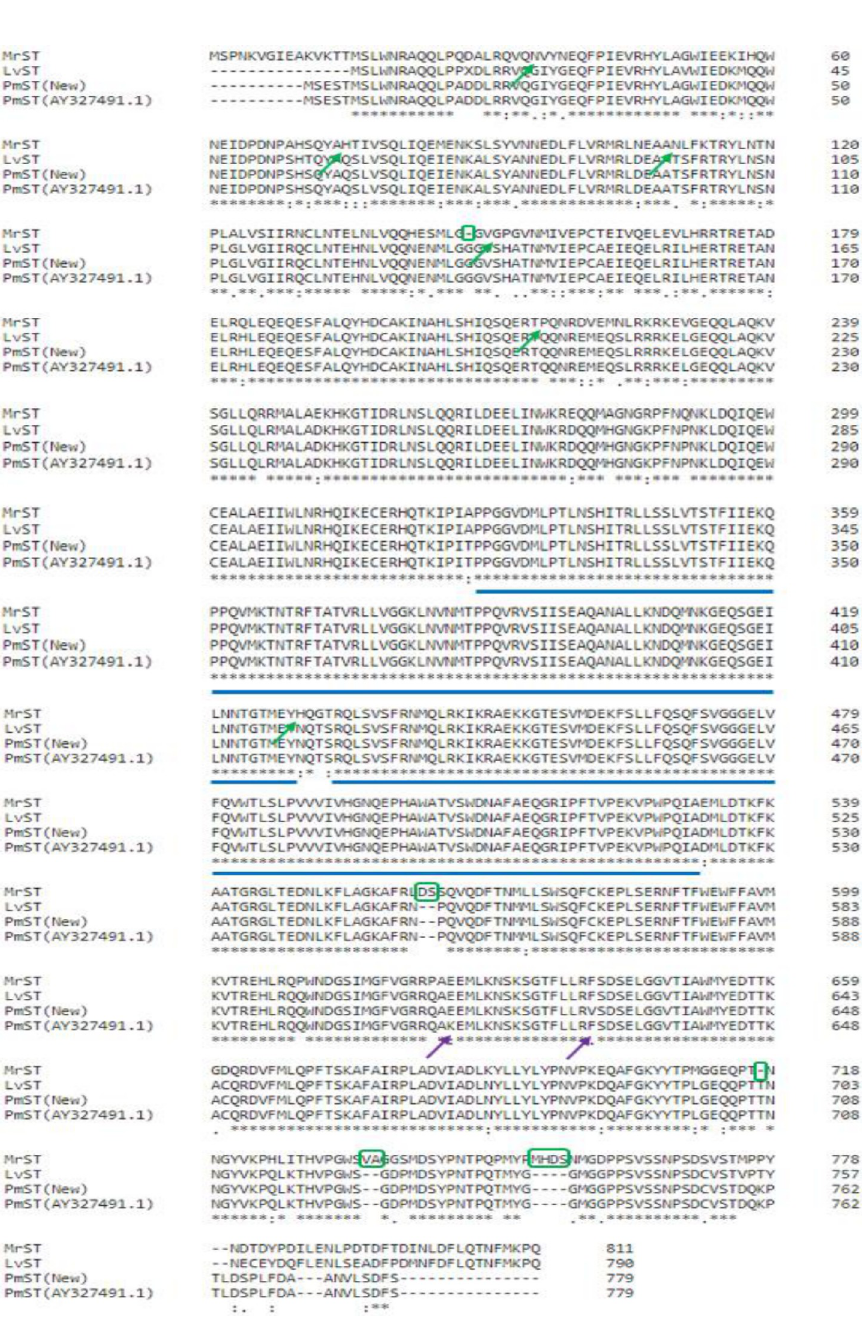
Fig 2. Sequence comparison of MrST, LvST, PmST (New) (disease tolerant strain), and PmST (Accession number: AY327491.1) translated amino acid sequences. � represents common conserved sites between all sequences. represents important long conserved overlaps between all sequences. represents important divergent sites between PmST (cross-bred disease tolerant strain) and PmST (Accession number: AY327491.1). represents important divergent sites between MrST and other STAT sequences. represents important amino acid addition or deletion between MrST and other STAT